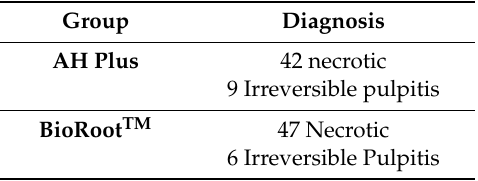
Table 1. Clinical diagnosis of recalled teeth ( n = 125) at baseline.